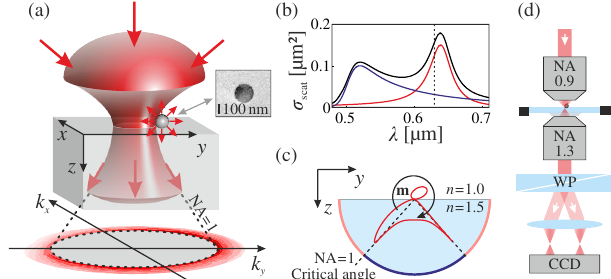
FIG. 2. Experimental concept and setup. (a) Sketch of an incoming tightly focused beam being probed by a silicon nano- particle sitting on a glass substrate. The light scattered and transmitted into the glass half-space is collected in the far field. Only the light emitted into the solid angle above the critical angle (NA ¼ 1 , indicated by the dashed black lines) is required. Blocking the light collected below NA ¼ 1 results in a ringlike far-field pattern visualized by red color coding. A scanning electron micrograph depicted in the inset shows the particle (the black scale bar indicates 100 nm). (b) Scattering cross section σ of a core-shell nanosphere (silicon core with a diameter of scat 158 nm and silicon dioxide shell with 8-nm thickness) calculated using Mie theory. (c) Directional emission (red line) of a transversely spinning magnetic dipole [dipole moment spinning clockwise, m ∝ ð 0 ; 1 ; { Þ , indicated by the black arrow] sitting on a glass substrate with refractive index n ¼ 1 . 5 . (d) Experimental setup. An incoming monochromatic beam of light ( λ ¼ 630 nm) is focused onto the nanosphere sitting on a glass substrate by a microscope objective with a NA of 0.9. The transmitted light is collected by a microscope objective with a NA of 1.3. A Wollaston prism (WP) is utilized to determine the polarization state ( x and y polarization) of the far-field pattern, which is measured by imaging the back focal plane of the lower micro- scope objective onto a CCD